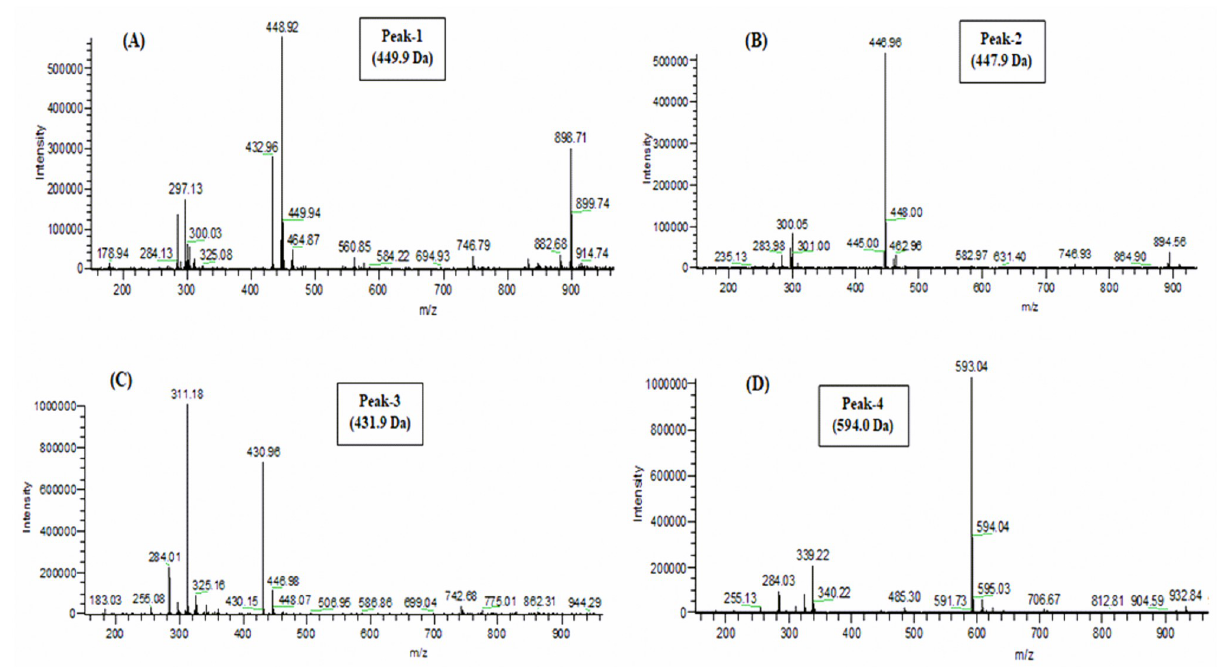
Fig 7. Molecular mass of peak samples of HWHF by LC-MS analysis. Peak fractions were separated on a Spectra System LC using a Kinetex 5 μ m F5 LC column (150 x 4.6 mm) (Phenomenex). The mass-to-charge ratio (m/z) versus peak intensity was determined. Samples of “peaks (P) 1 to 4” with retention times of 19, 20, 23 and 28 min were used to determine the molecular weights of unknown compounds with m/z 449.9, 447.9, 431.9 and 594.0 Da, respectively.